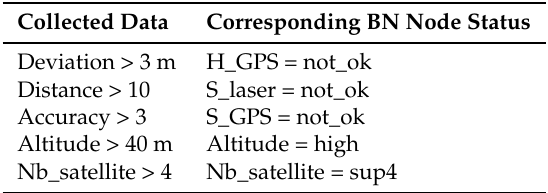
Table 8. Interpretation of raw data into BN node